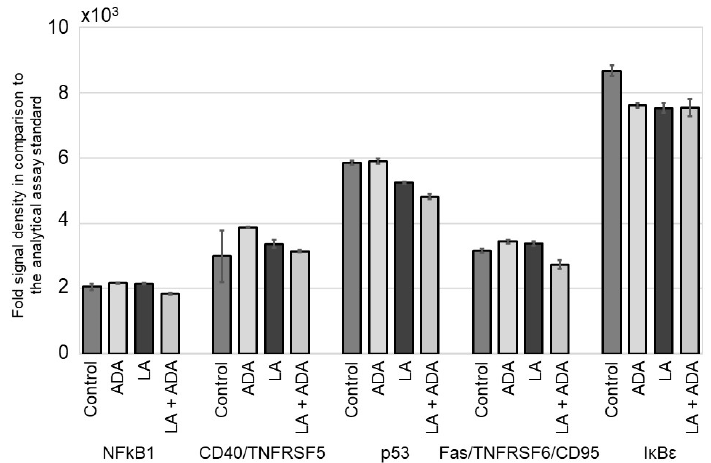
Figure 2. Evaluation of the NF κ B signal pathway members NFkB1, CD40/ TNFRSF5, p53, Fas/TNFRSF6/CD95, and I κ B ε in human SZ95 sebocytes after 24 h pre-incubation with linoleic acid (LA, 10 − 4 M) and subsequent treatment with LA, adalimumab (ADA, 30 µ g/mL), or LA and ADA over 3 days. Comparative quantification of the obtained data against the analytical assay